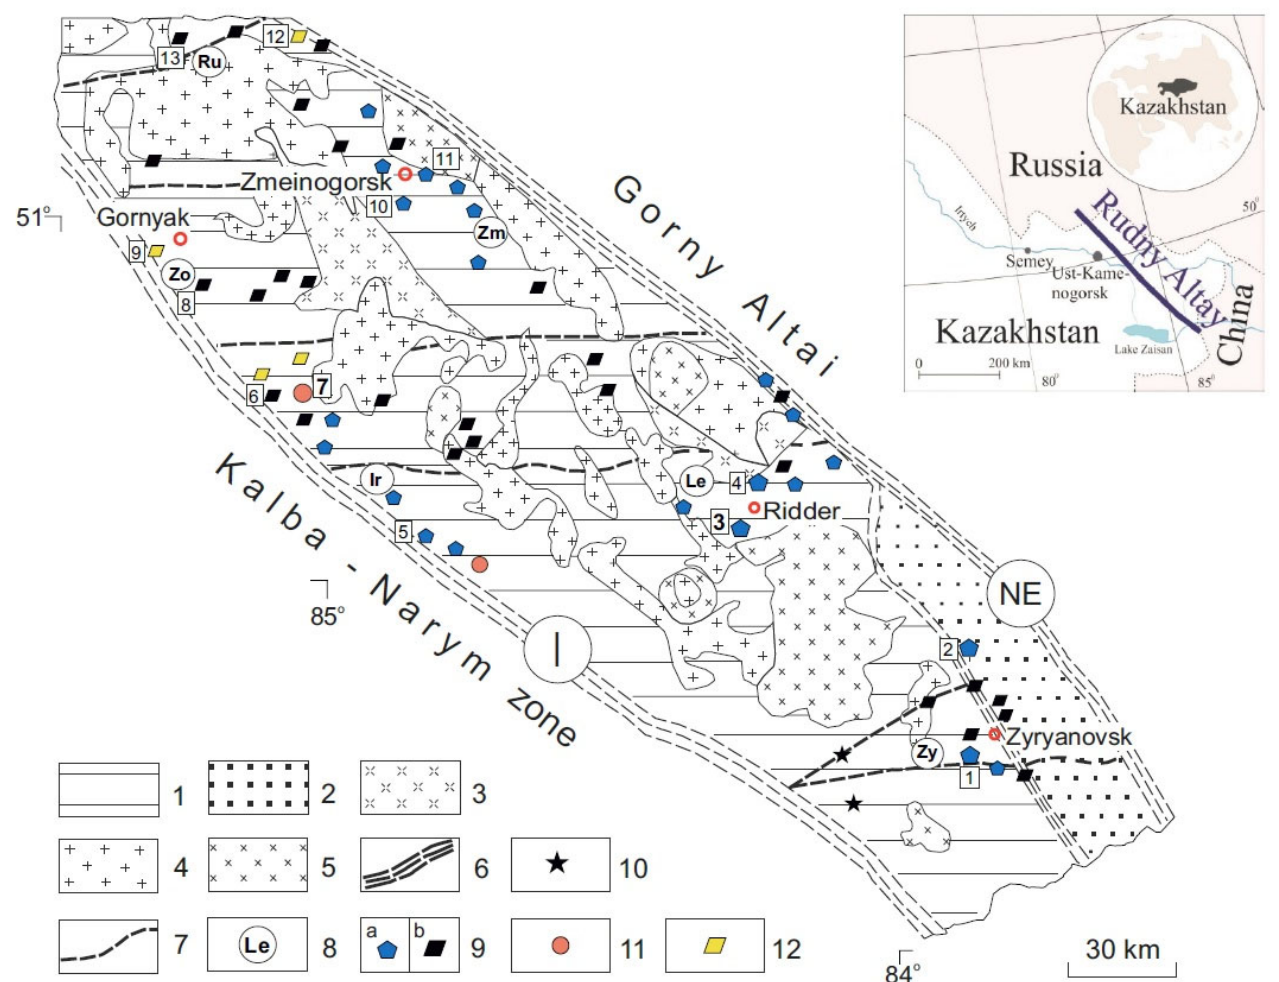
Figure 2. Local geology of Rudny Altai, after Gaskov [36]. 1 = Middle-Upper Devonian island-arc volcano-sedimentary rocks of Rudny Altai; 2 = Belaya Uba-Maymyr back-arc basin; 3 = Pre-Eifelian (D2) complex of diorite, quartz diorite, granodiorite, and plagiogranite; 4 = Middle Devonian (D2) Zmeinogorsk complex of granodiorite, diorite, plagiogranite, and adamellite; 5 = Middle Devonian (D2) Kalba complex of porphyritic biotite and biotite-hornblende granites; 6 = border faults between orogenic systems: Irtysh (Irt) and North-East (NE) shear zones; 7 = cross faults; 8 = ore districts; 9–12 = mineral deposits: 9 = VMS deposits with sulfide-base metal (a) and base metal (b), 10 = Pb-Zn deposits, 11 = Cu deposits, 12 = Au and base metal deposits. Numbers in squares are individual deposits in ore districts: Zyryanovsk (1) and Maleevsk (2) deposits in Zyryanovsk (Zy) district, with; Ridder = Sokolny (3) and Novy Leninogorsk deposits (4) in Leninogorsk (Le) district; Irtysh (5), Nikolaevsk (6), and Artemiev (7) deposits in Irtysh (Ir) district; Zolotukhino (8) and Orlovka (9) deposits in Zolotushino (Zo) district; Zmeinogorsk (10) and Korbalikha (11) deposits in Zmeinogorsk (Zm) district; Talaya (12) and Rubtsovsk (13) deposits in Rubtsovsk (Ru) district.